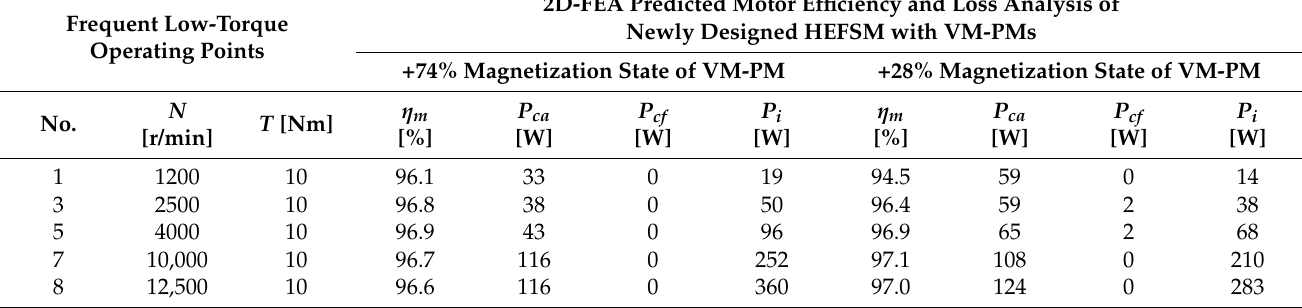
Table 7. 2D-FEA predicted motor efficiency and loss analysis results.